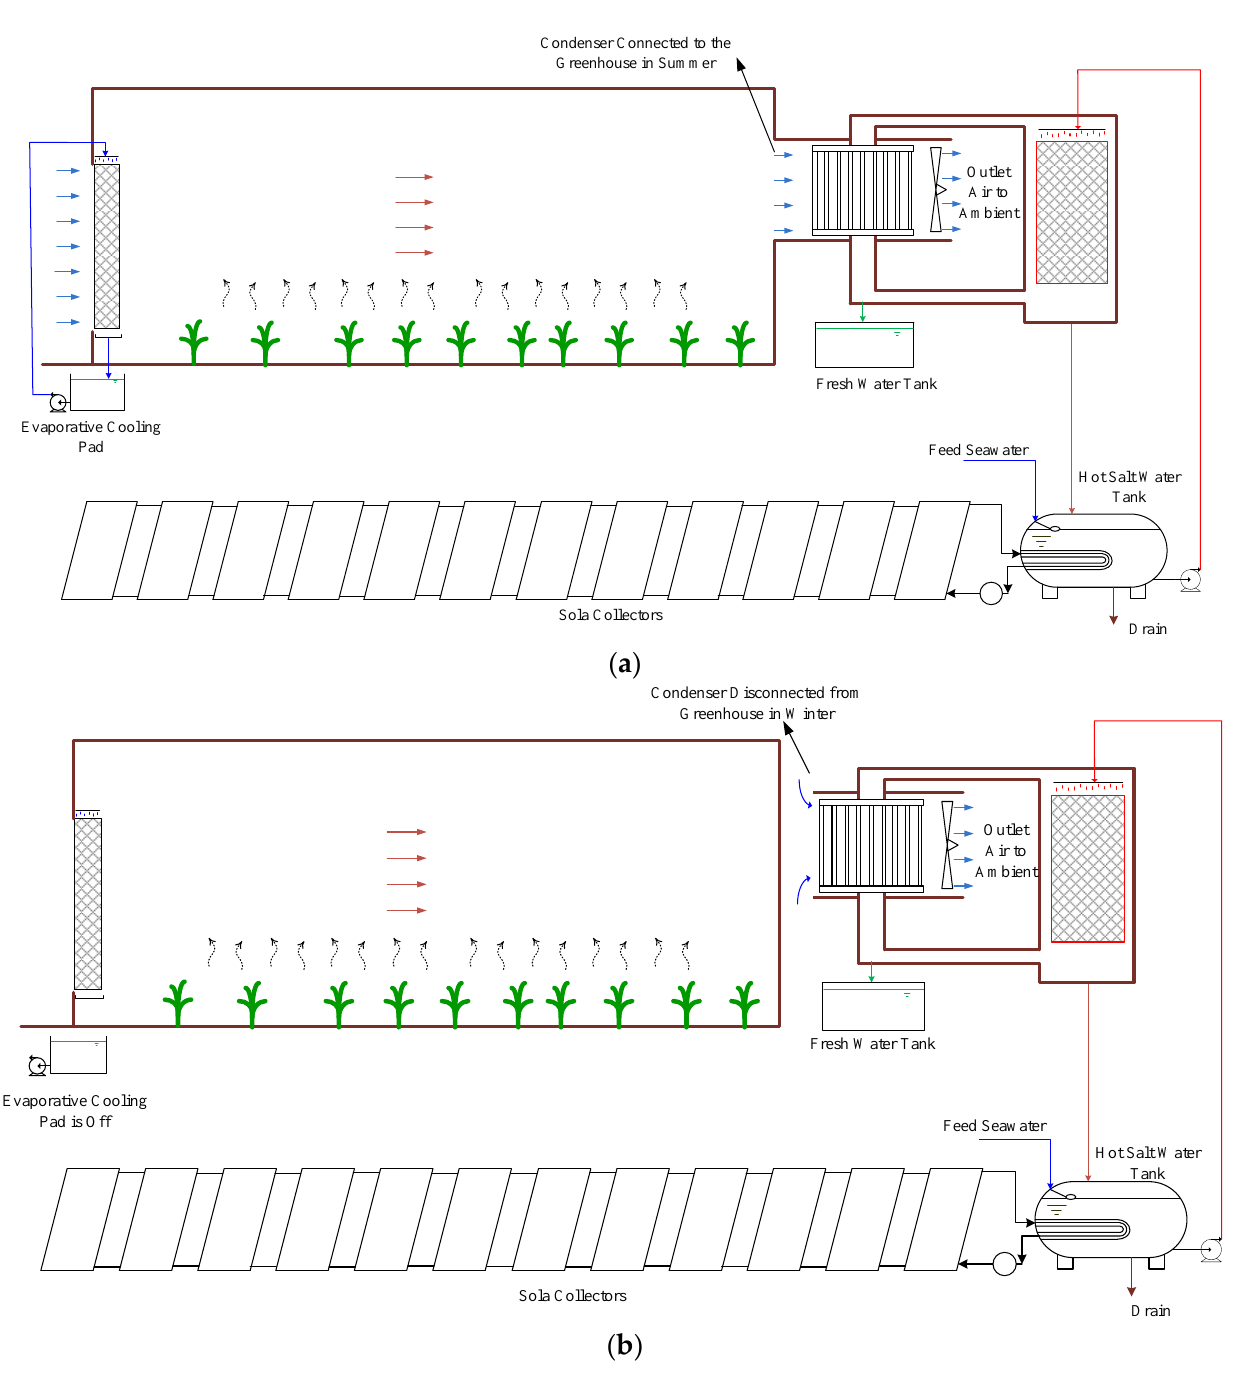
Figure 1. Proposed seawater greenhouse equipped with HD desalination unit on ( a ) hot days, and ( b ) cold days.